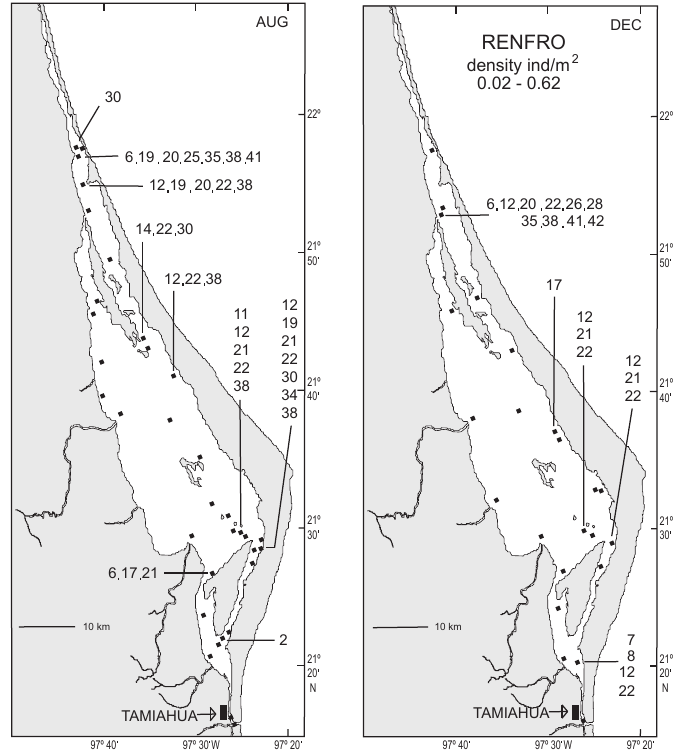
Fig. 2. Laguna de Tamiahua, Gulf of Mexico, Mexico—fish sampling in 1996 with a Renfro beam net; August = left : 2 = Ariopsis felis , 6 = Opsanus beta , 11 = Gobiosoma bosc , 12 = Gobiosoma robustum , 14 = Lucania parva , 17 = Achirus lineatus , 19 = Hippocampus zosterae , 20 = Syngnathus floridae , 21 = Syngnathus louisianae , 22 = Syngnathus scovelli , 25 = Lutjanus griseus , 30 = Eucinostomus melanopterus , 34 = Chaetodipterus faber , 35 = Bairdiella chrysoura , 38 = Cynoscion nebulosus , 41 = Archosargus probatocephalus ; December = right : 6 = Opsanus beta , 7 = Eleotris pisonis , 8 = Ctenogobius boleosoma , 12 = Gobiosoma robustum , 17 = Achirus lineatus , 20 = Syngnathus floridae , 21 = Syngnathus louisianae , 22 = Syngnathus scovelli , 26 = Lutjanus synagris , 28 = Eucinostomus argenteus , 35 = Bairdiella chrysoura , 38 = Cynoscion nebulosus , 41 = Archosargus probatocephalus , 42 = Lagodon rhomboides